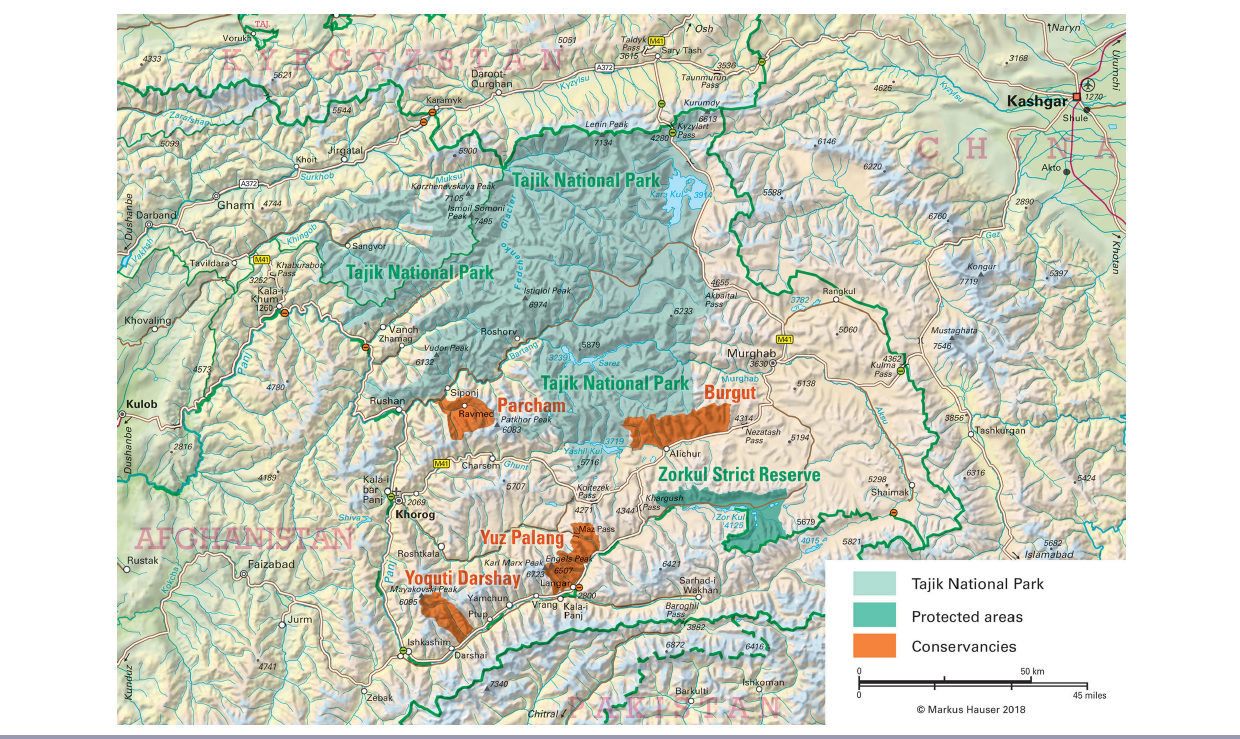
Fig. 1 . Map of the conservancies and protected areas in the Pamir region of